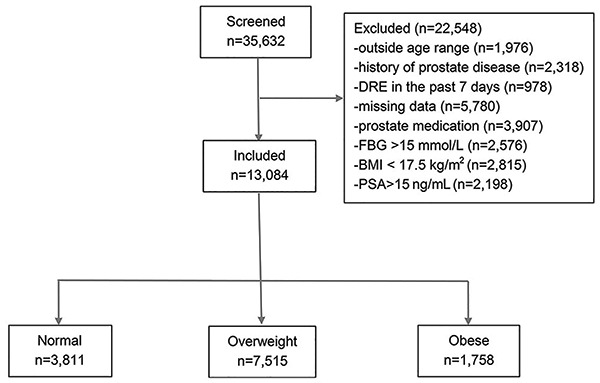
Flowchart of the included men.